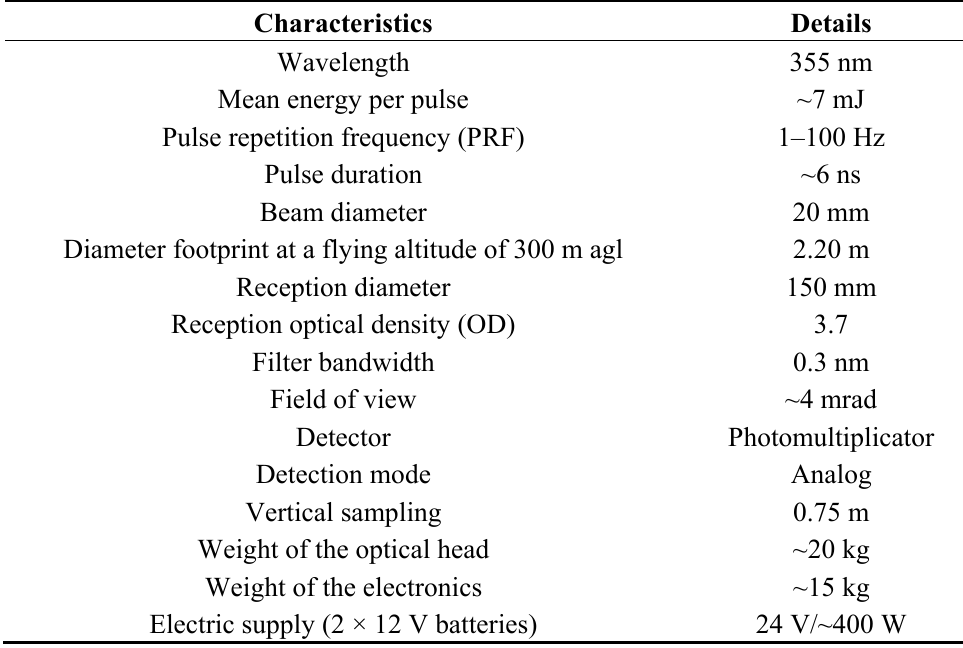
Table 2. Characteristics of the ULICE a .